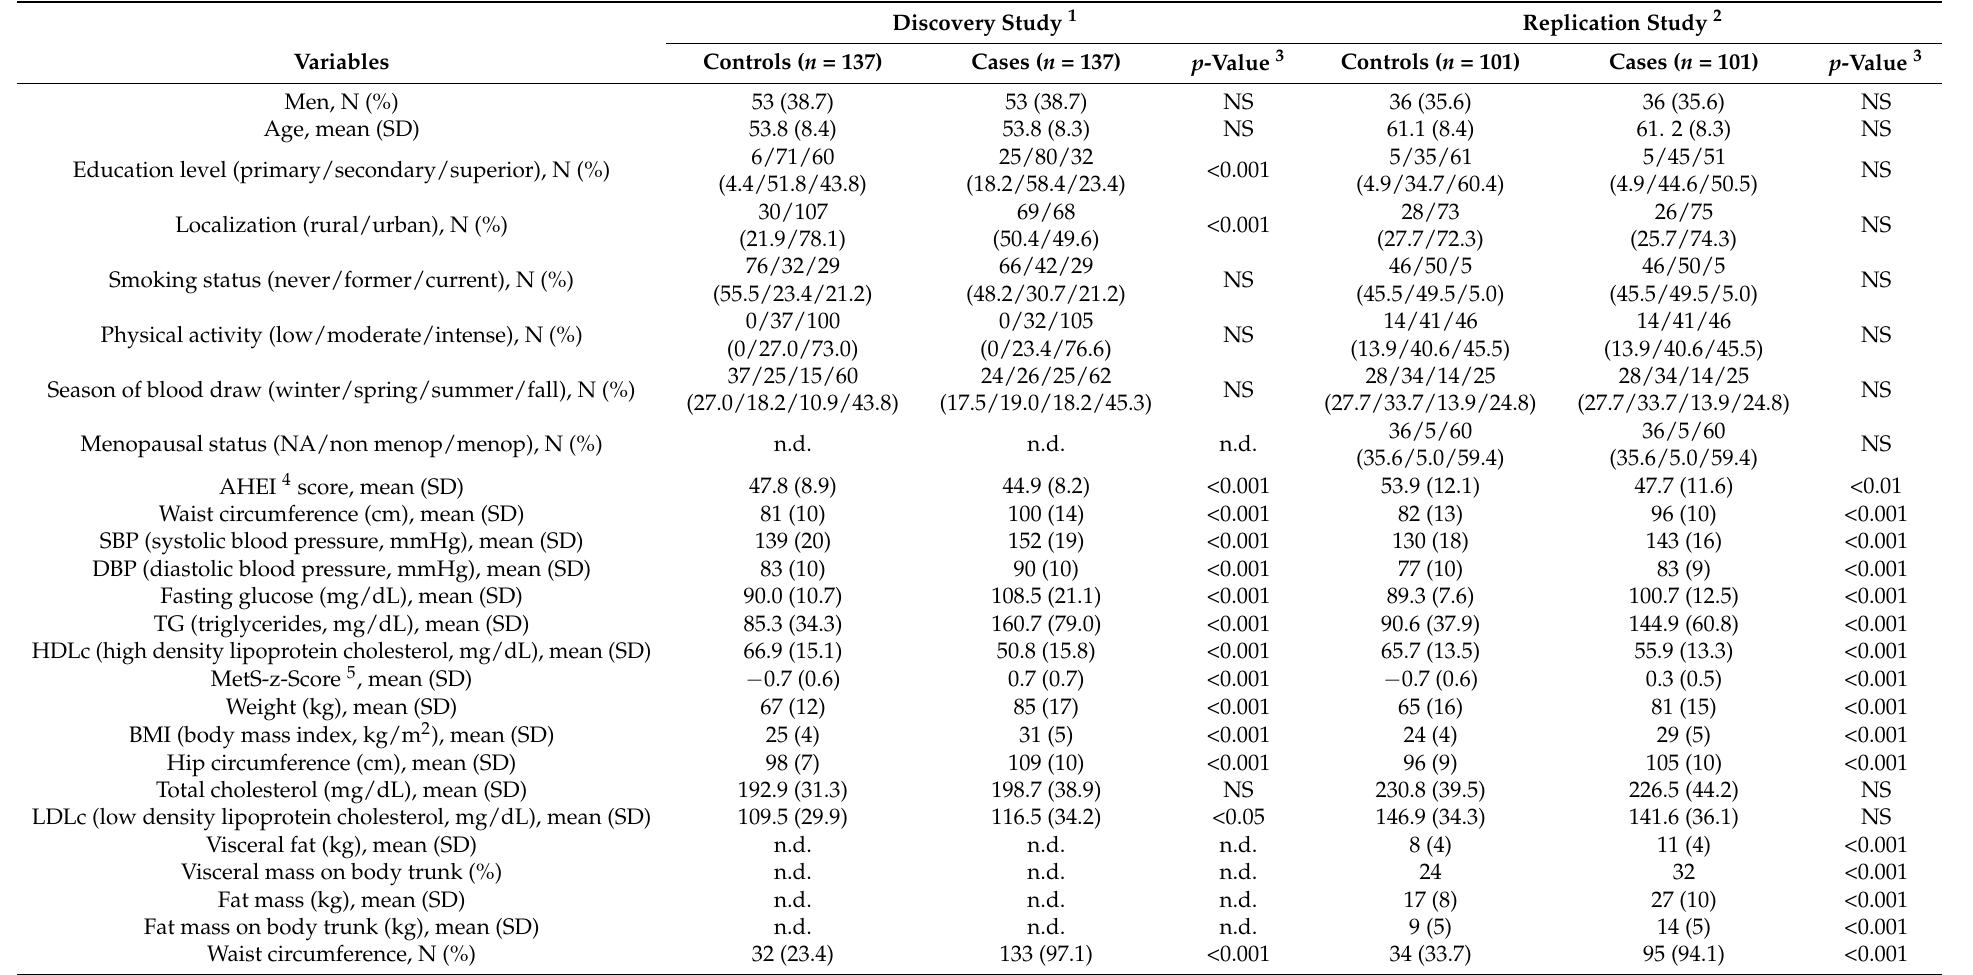
Table 1. Baseline characteristics of the population selected for the Discovery and Replication